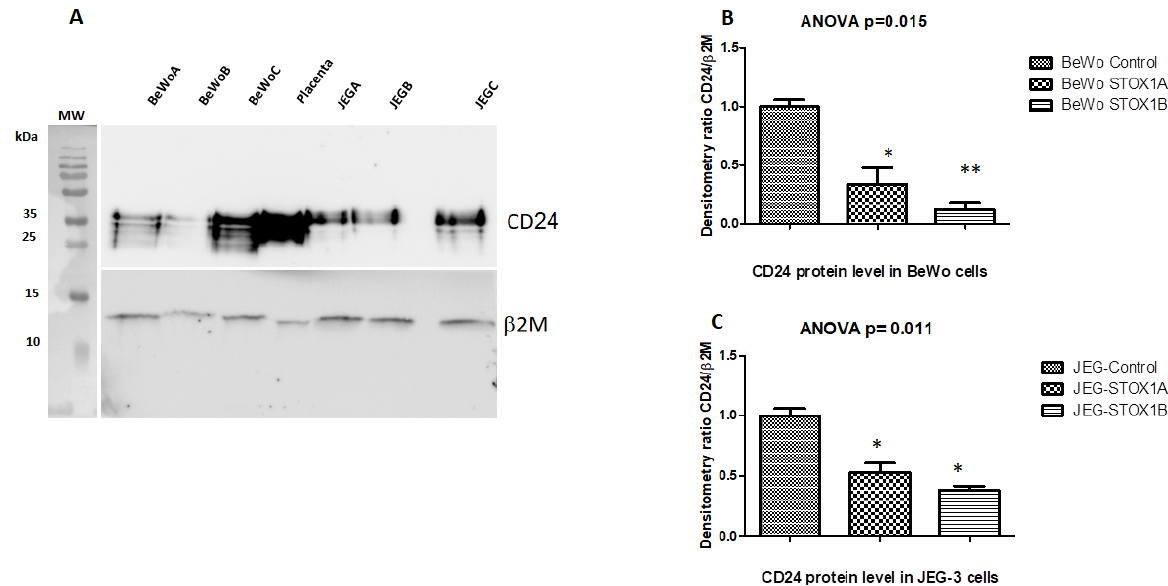
Figure 2. Western blot analyses of the CD24 expression in STOX1-A/B-stably transfected BeWo and JEG-3 cells. ( A ) Western blot analysis of the CD24 protein expression in trophoblast cell transfectants by STOX1-A/B and mock control of BeWo cells and of JEG-3 cells. CD24 was analyzed by Western blotting with a specific anti-CD24 monoclonal antibody (upper panel). Beta2-microglobulin was used as a control for loading equal amounts of proteins on the gel (lower panel). ( B , C ) Semiquantitative densitometric assessment of CD24 and B2-microglobulin bands was performed using ImageJ software. The data represents density at two exposure time points. The intensity of the CD24 bands was normalized to β 2-microglobulin as a control for the equal loading of proteins. The results have a similar pattern in three different repeats. The statistic is based on one-way ANOVA followed by a post hoc test: Student–Neumann–Keuls. The stars were obtained by comparing controls vs. STOX1-A and STOX1-B, separately (* p < 0.05 and ** p < 0.01). The figure is representative of the Western blot experiments that were conducted three times and showed a similar pattern of CD24 reduction. The histogram error bars are SEM.